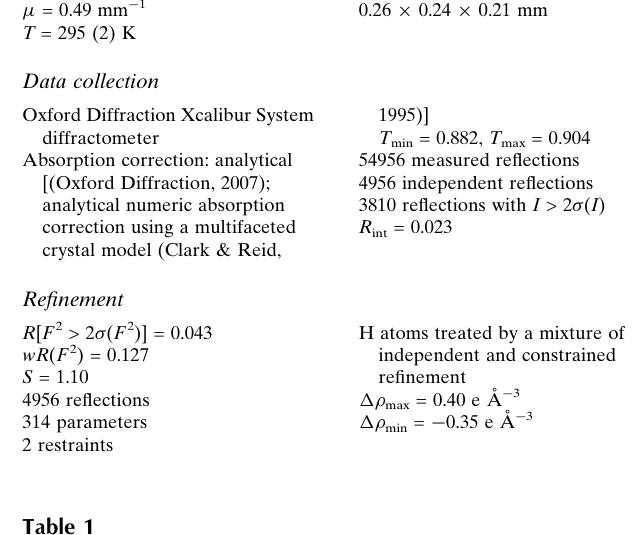
Hydrogen-bond geometry (A˚ , (cid:1)